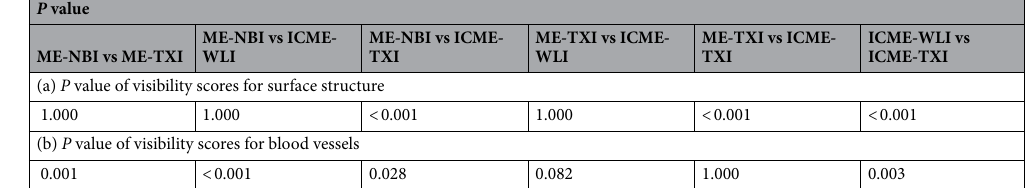
Table 2. P value of visibility scores of SNADETs in ME-TXI, ICME-WLI, and ICME-TXI compared to ME-NBI. The ME-NBI was set as score 0. P value was calculated using Friedman’s test with Bonferroni correction. SNADETs superficial nonampullary duodenal epithelial tumors, ME-WLI magnified endoscopy with white-light imaging, ME-NBI magnified endoscopy with narrow-band imaging, ME-TXI magnified endoscopy with texture and color enhancement imaging, ICME-WLI indigo carmine dye with ME-WLI, ICME-TXI , indigocarmine dye with